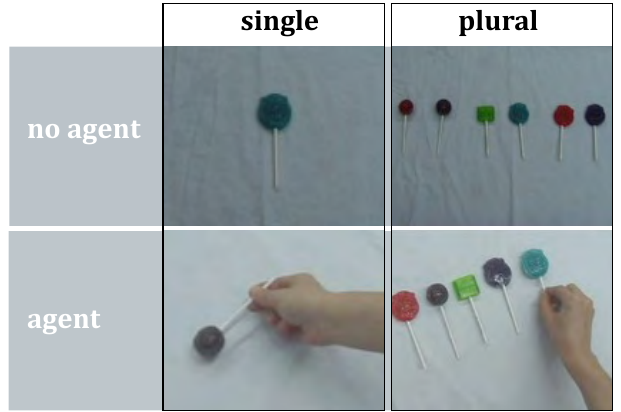
Fig. 1. Sample stimuli images showing four of eight conditions: single no agent (lollipop alone, upper left image); plural no agent (lollipops in a row, upper right image); single agent (put lollipop alone, lower left image); and plural agent (put lollipops in a row, lower right